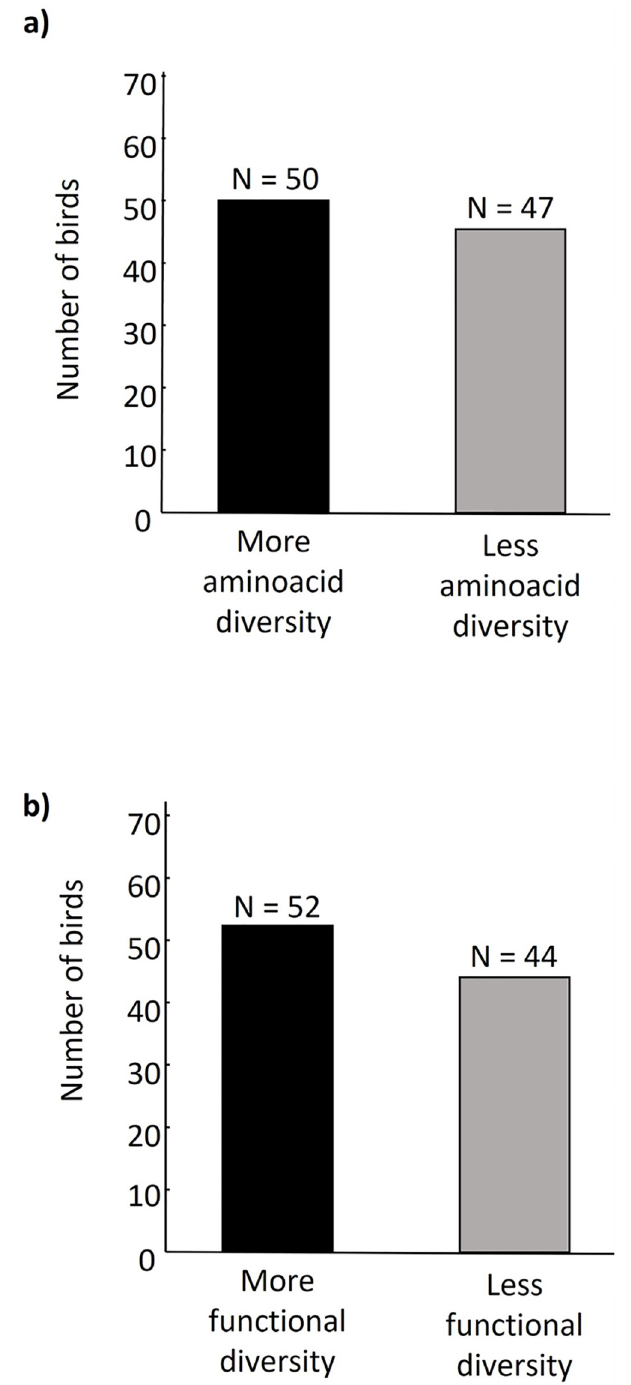
Fig 2. Number of birds that chose the side of the olfactometry chamber containing the scent of a conspecific of the opposite sex with greater (black) or lower (grey) a) MHC-I amino acid diversity or b) MHC-I functional diversity.